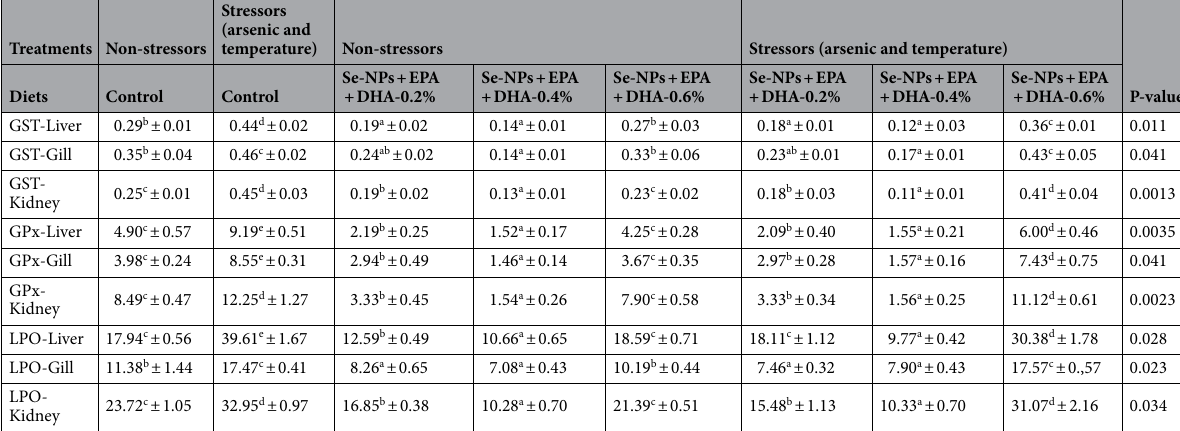
Table 4. Mitigation of secondary stress response (glutathione-s-transferase (GST), glutathione peroxidase (GPx) and lipid peroxidation (LPO)) through dietary supplementation of selenium nanoparticles, eicosapentanoic acid and dicosahexanoic acid fed to P. hypophthalmus reared in control or under arsenic and high temperature for 105 days. Values in the same row with different superscript (a, b, c, d, e) differ significantly. Data expressed as Mean ± SE (n = 6). GST and GPx: Units/mg protein. LPO: n mole TBARS formed/h/mg